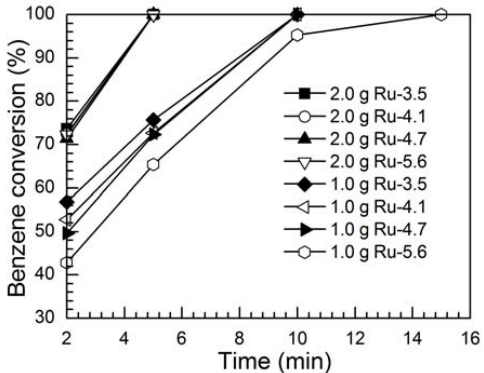
= 50.0 g, v H = 280 mL, v benzene = 140 mL, T = 423 K, 4 2 O